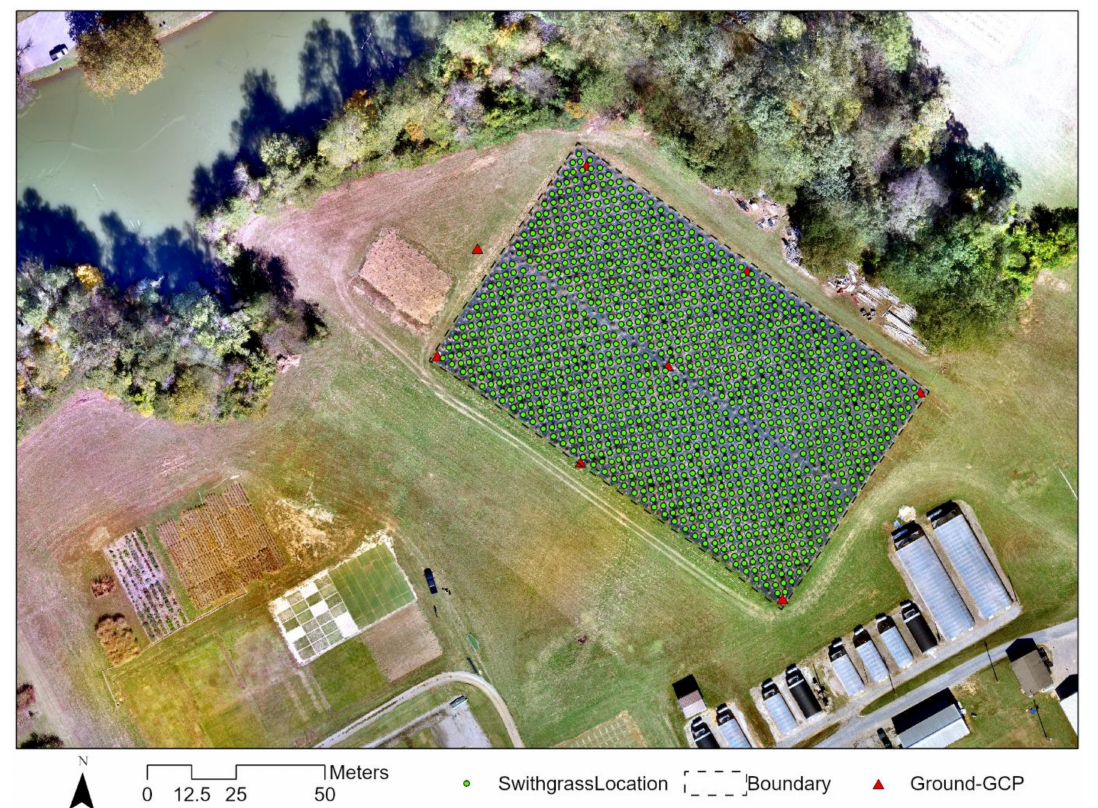
Figure 6. Field map of the switchgrass locations and ground control points (GCP). The color map is the composite of the R, G, and B bands collected with the Zenmuse camera. A total of eight control points (including one ground station), as shown in red triangles, were surveyed in the field. The Global Positioning System (GPS) antenna was manufactured by CHC Navigation (Shanghai Huace Navigation Technology Ltd., Shanghai, China). It is a static GPS, post-processing used Online Positioning User Service (OPUS) to resolve the high-accuracy positioning. The eight control points were collected in the field from 5 to 30 September 2019. The field ground- and UAV-based data for the four sustainability traits were collected at several time points (Table 4). Data collection for chlorophyll was at one time-point (mid-season), for rust disease at one time-point (mid-season), and for nitrogen and lignin at two time-points (mid-season and end of the